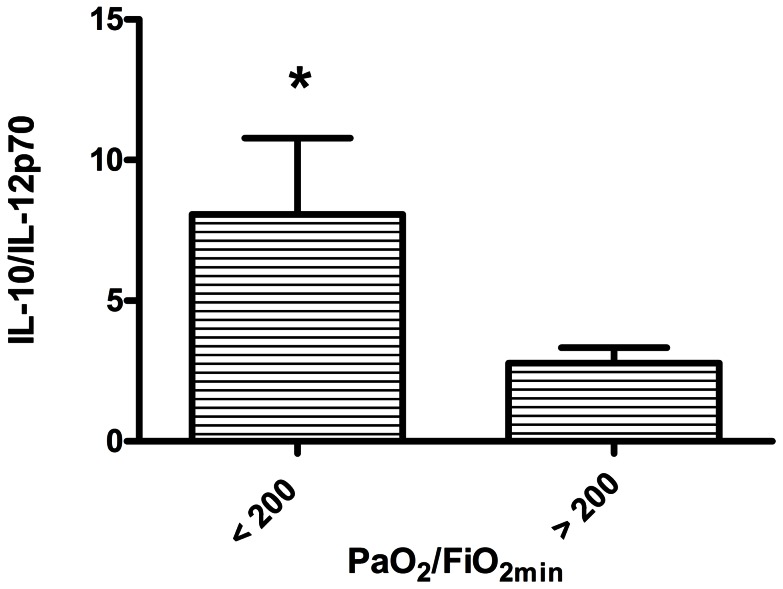
Comparison of IL-10 to IL-12p70 ratios in mainstem bronchial washings, between patients with the lowest PaO2/FiO2 ratios during the first 2 weeks post injury (PaO2/FiO2) of <200 (N = 16), and patients with PaO2/FiO2 ≥200 (N = 24).Bars represent mean ± SE. * P<0.05, t-test with Welch's correction for unequal variances.